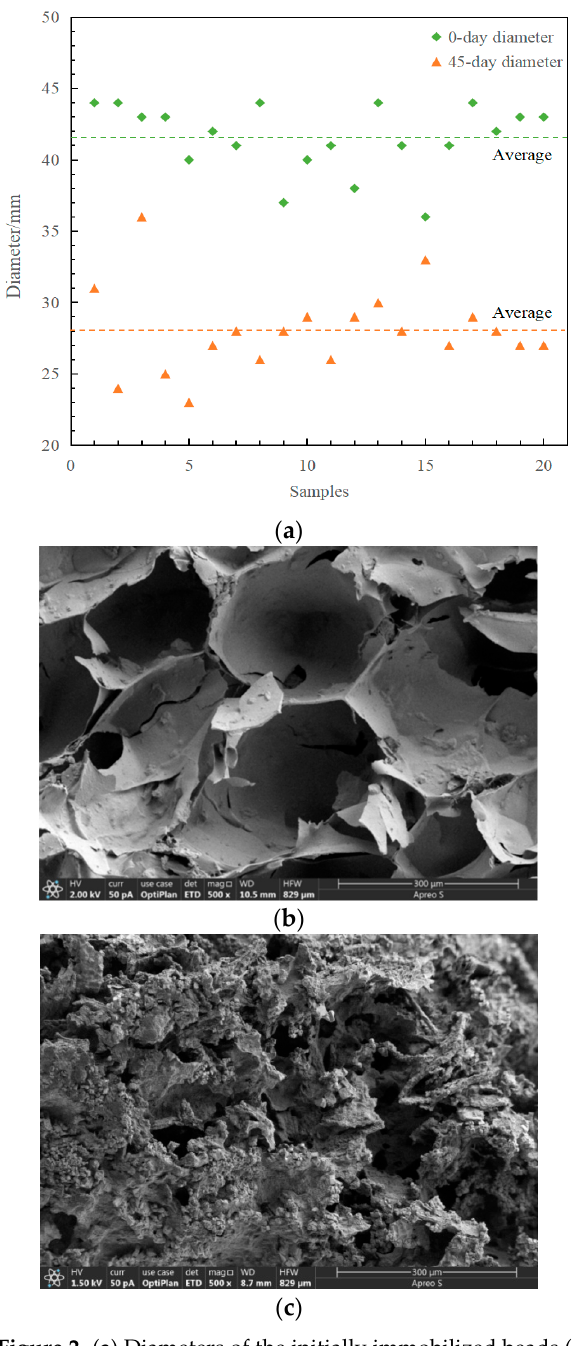
Figure 2. ( a ) Diameters of the initially immobilized beads ( ◆ in green) and the immobilized beads in the bioreactor after 45 days ( ▲ in orange). Interior structural changes in ( b ) the initial immobilized beads and ( c ) the immobilized beads in the bioreactor after 45 days recorded by SEM.